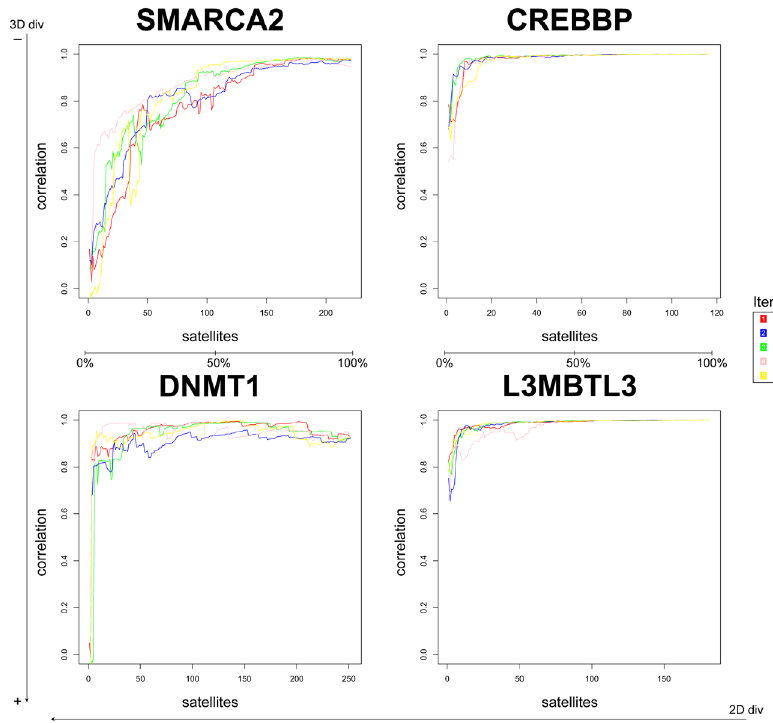
Figure 2. Backwards analysis with 2PCs picking satellites at random. The correlation with the results from the whole matrix was calculated with increasing numbers of satellites. Each colored line represents one of the five iterations.